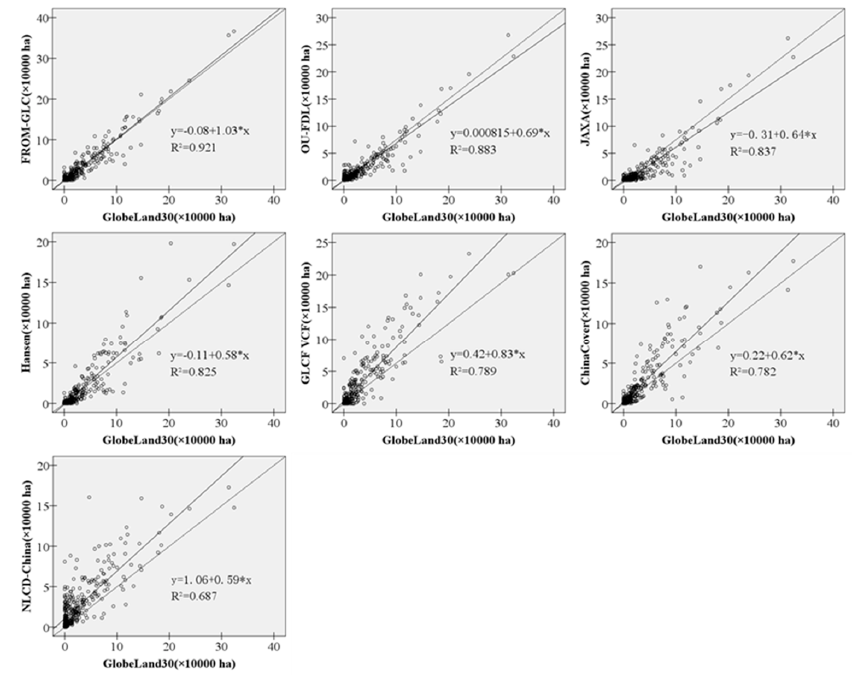
Figure 5. Relationships of different forest products in terms of county-level areas, using the GlobeLand30 forest map as the reference.